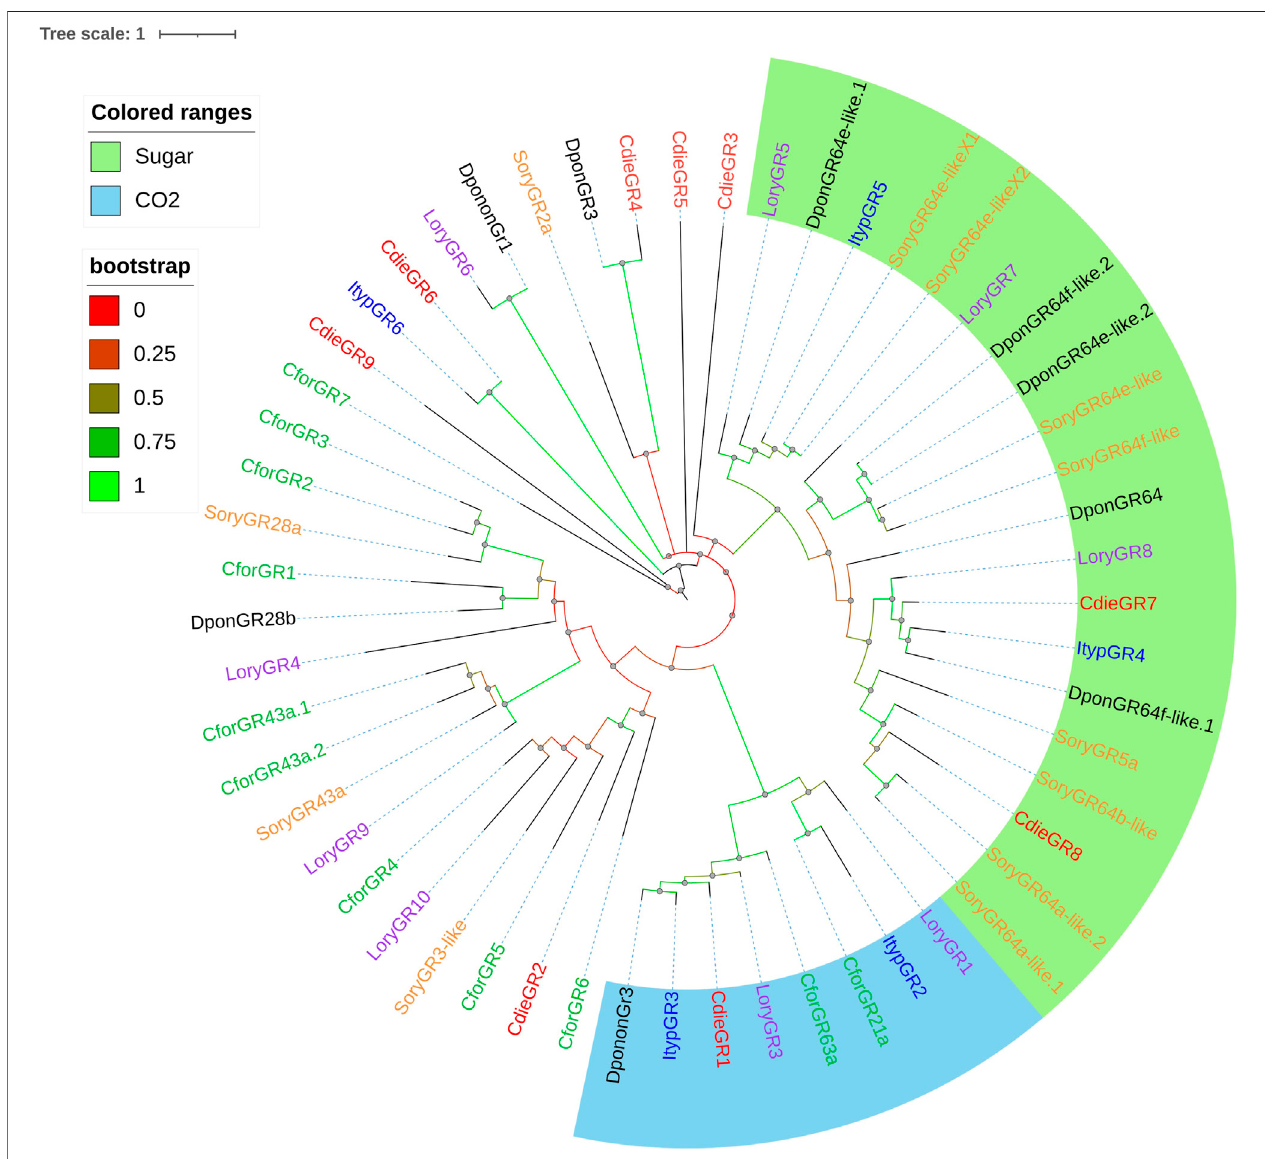
FIGURE 8 | Maximum likelihood phylogenetic tree of candidate GRs in C. dieckmanni (Cdie, red), Dendroctonus ponderosae (Dpon, black), Lissorhoptrus oryzophilus (Lory, purple), Ips typographus (Ityp, blue), and Cylas formicarius (Cfor, green). The scale bar represents the 1 amino acid substitutions per site.